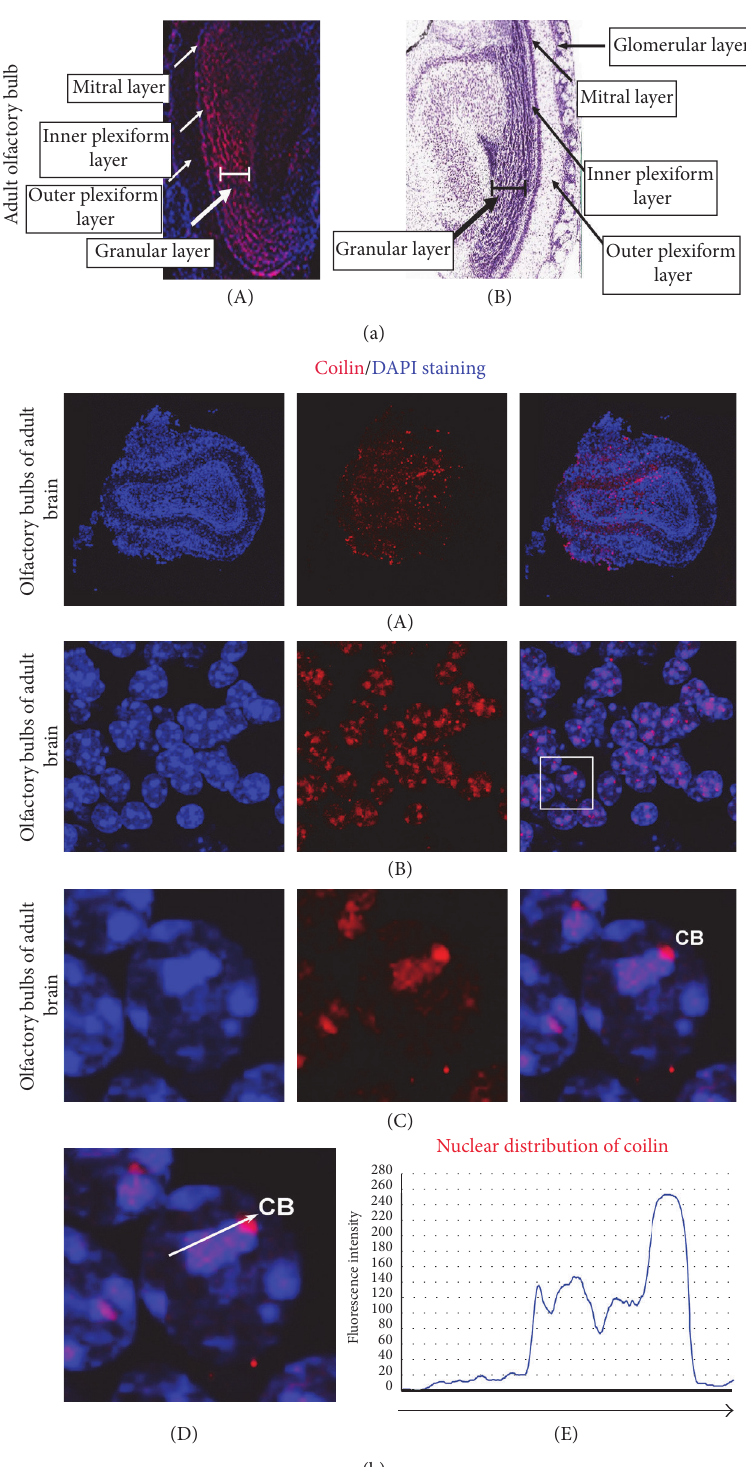
Figure 3: Coilin expression in the olfactory bulbs (OBs) of the adult brain. ((a)(A)) The OB regions of an adult mouse brain visualized by DAPI staining (blue) and an antibody against acetylated histone H3 (red; an antibody raised against H3K9ac [#06-942, Merck Millipore] was used to visualize the granular layer of OB due to its high density). The morphology of the OB in ((a)(A)) is compared with the morphology of the OB according to ((a)(B)) the brain atlas (see [31]). ((b)(A)–(b)(D)) show coilin accumulation in the Cajal bodies. In adult OBs, CBs were surrounded by DAPI- and coilin-dense regions (red and blue) (see (b)(C)). ((b)(D)) shows a magnification of the cell nucleus from OB. ((b)(E)) indicates the density of coilin, visualized by Alexa 594 fluorescence, analyzed across the selected region delineated by a white arrow in